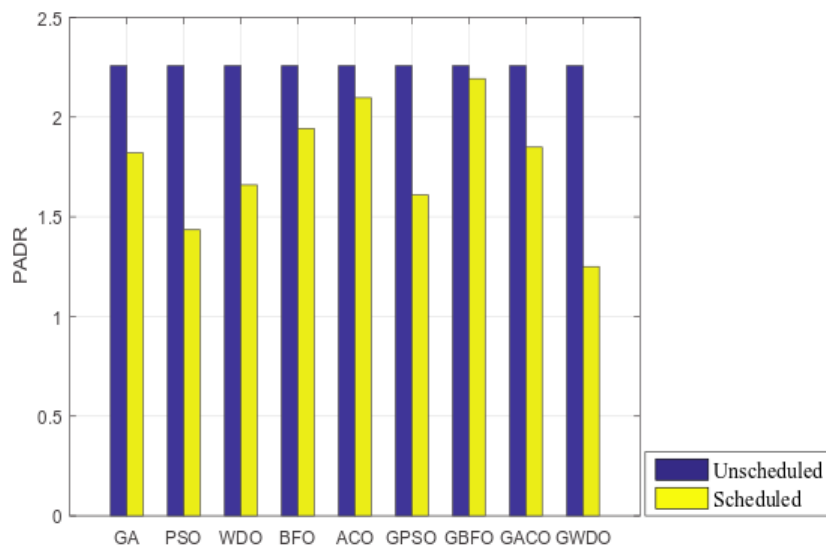
Figure 10. Case study 2: PADR